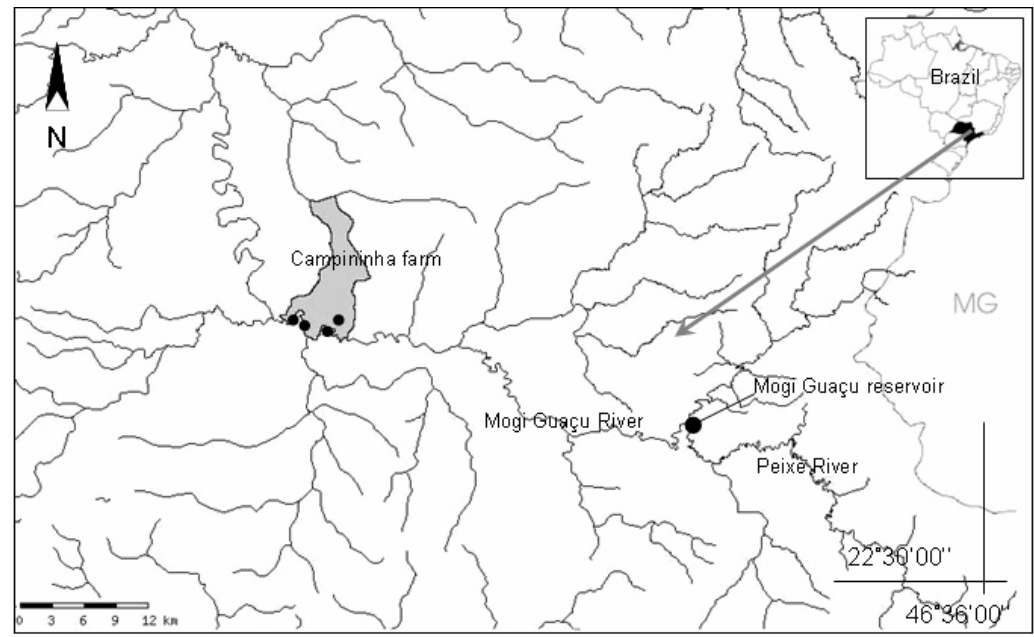
Map of the state of São Paulo showing the the sample sites (black dots) in the study areas: Mogi Guaçu reservoir and Ecological Station (Campininha farm) oxbow lakes. Map modified from CRIA (Centro de Referência em Informação Ambiental; Electronic Database accessible at http:// www.cria.org.br. Captured on 02 November